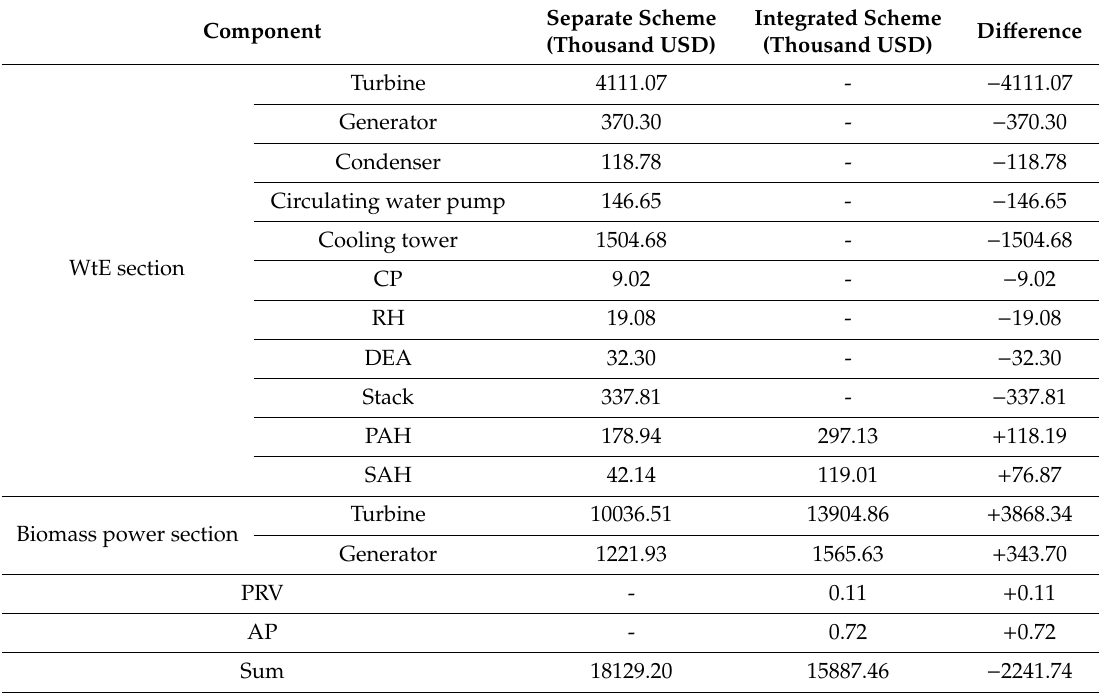
Table 13. Capital costs of the changed equipment. CP: condensate pump and AP: additional